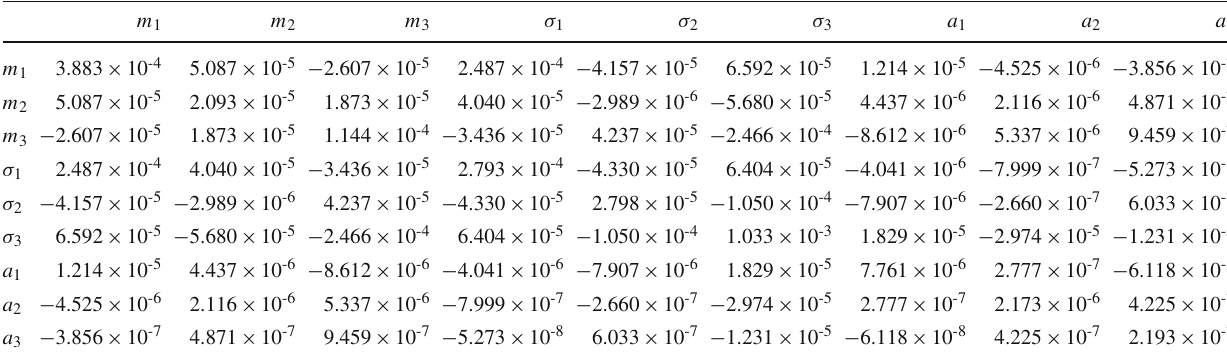
Table 6 Covariance matrix for the parametrization of the energy-loss function for molecular deuterium, as provided in Table